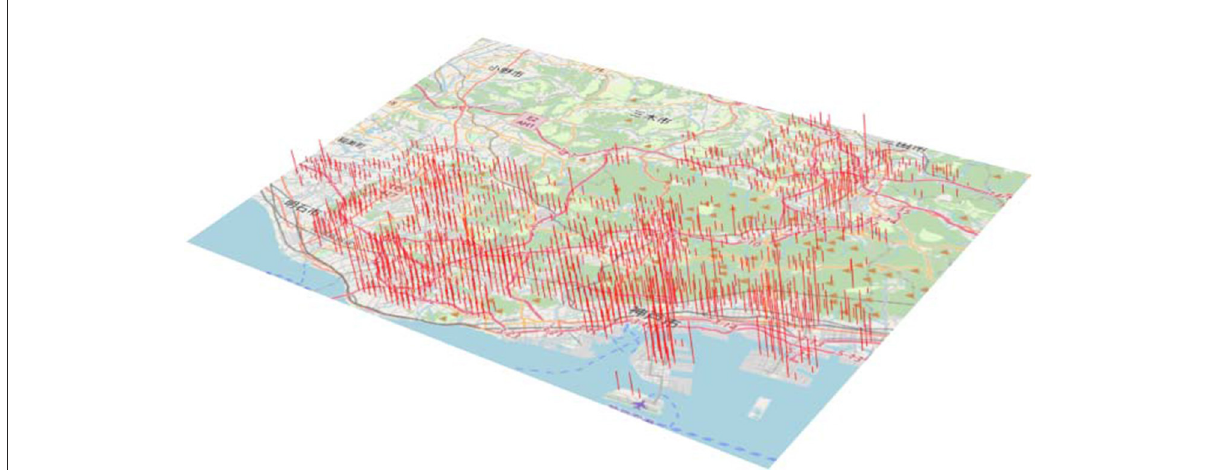
FIGURE7 Figure inferring buildings from nighttime light data in Hyogo Prefecture.